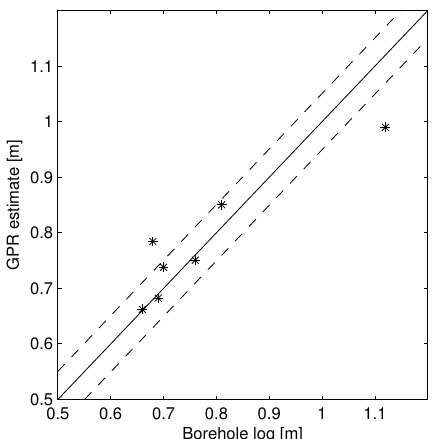
Fig. 7. Assessment on the accuracy of the multi-channel GPR for the estimates of reflector depths with borehole logs. Dashed lines stand for a standard deviation of